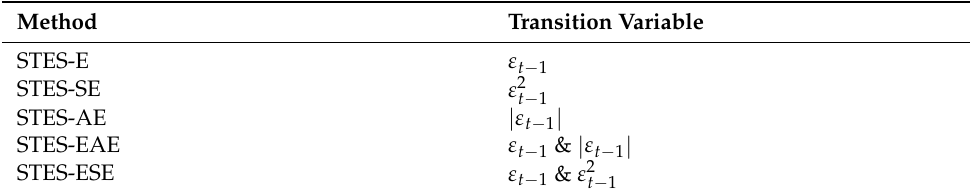
Table 3. Transition variables for the STES